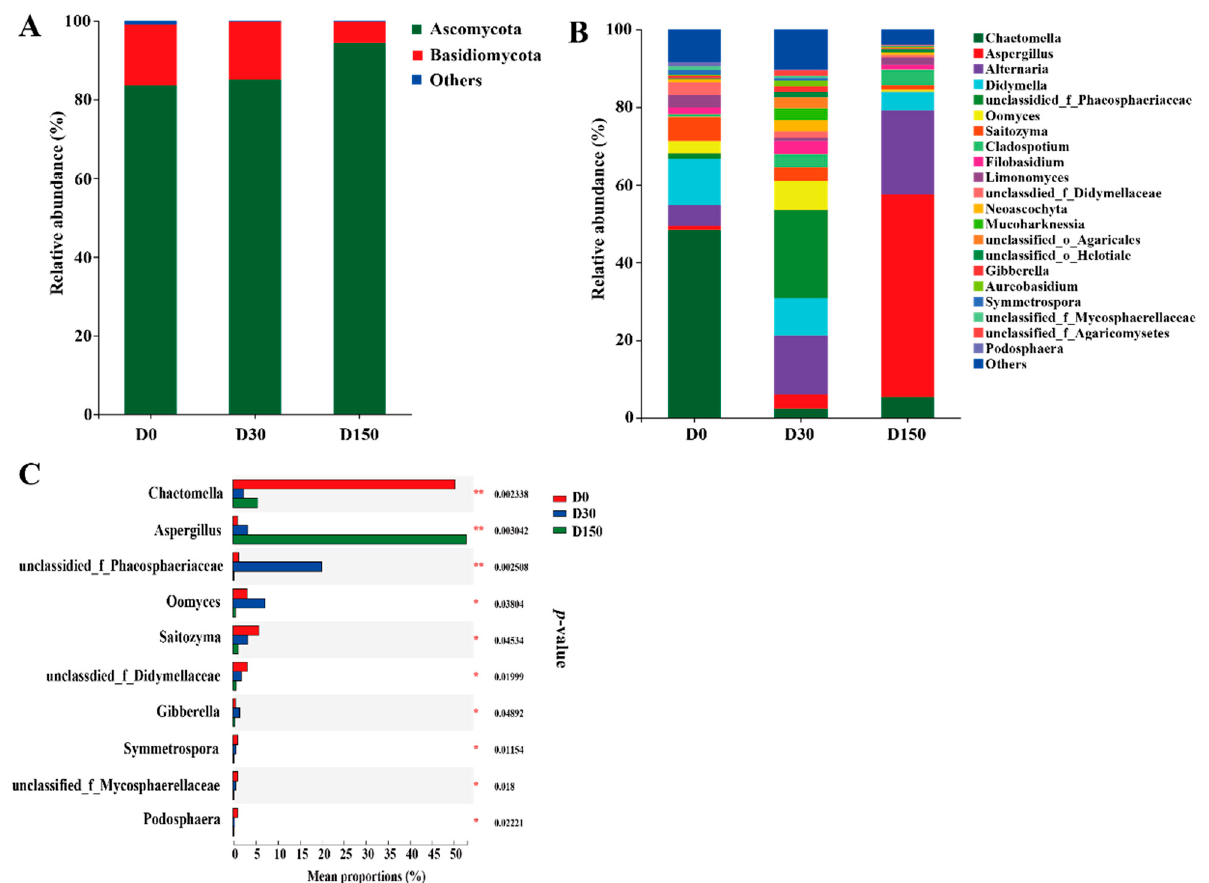
Figure 3. Fungal community structure across the three storage times (n = 6). ( A ) Phylum-level compositions of the fungal community in the three storage times. ( B ) Genus-level compositions of the fungal community in the three storage times. ( C ) The extended error bar plot displaying the significant differences among storage periods at the genus level. D0, storage at 0 d; D30, storage 30 d; D150, storage 150 d.